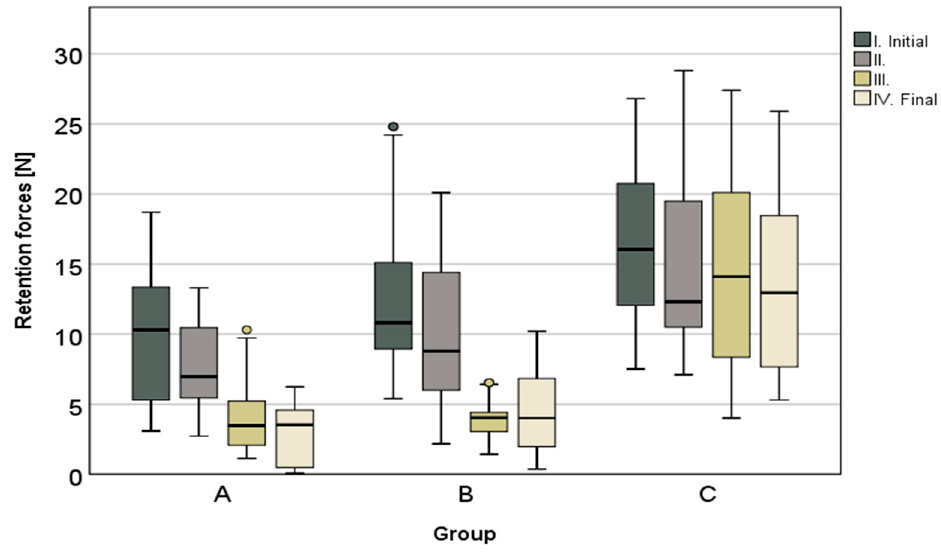
Figure 3. Box plots; median retention force values of all groups at each time of measurement.